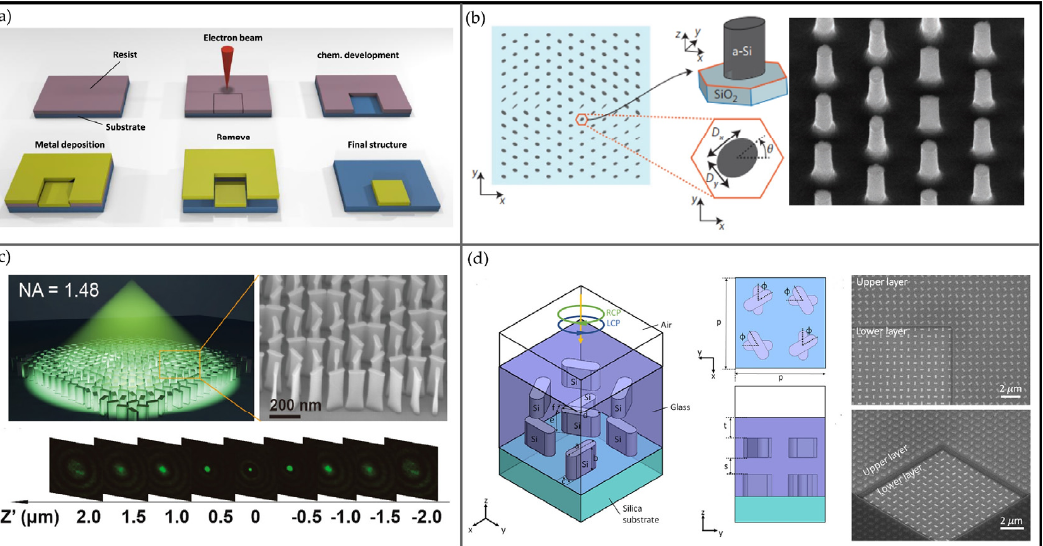
Figure 6. ( a ) The general process of the EBL approach, reprinted from [110] . Copyright 2022 IOP Publishing Ltd.; ( b ) the Si metasurface achieved complete control of phase and polarization. Reprinted from [39]. Copyright 2015, Nature Publishing Group; ( c ) the SEM of EBL-fabricated large-scale Si geometric phase metalens, and the imaging results of the lens at different positions. Reprinted with permission from [109]. Copyright 2018 American Chemical Society; ( d ) the schematic diagram and SEM image of a chiral bilayer Si metasurfaces. Reprinted with permission from [111]. Copyright 2020 American Chemical Society.